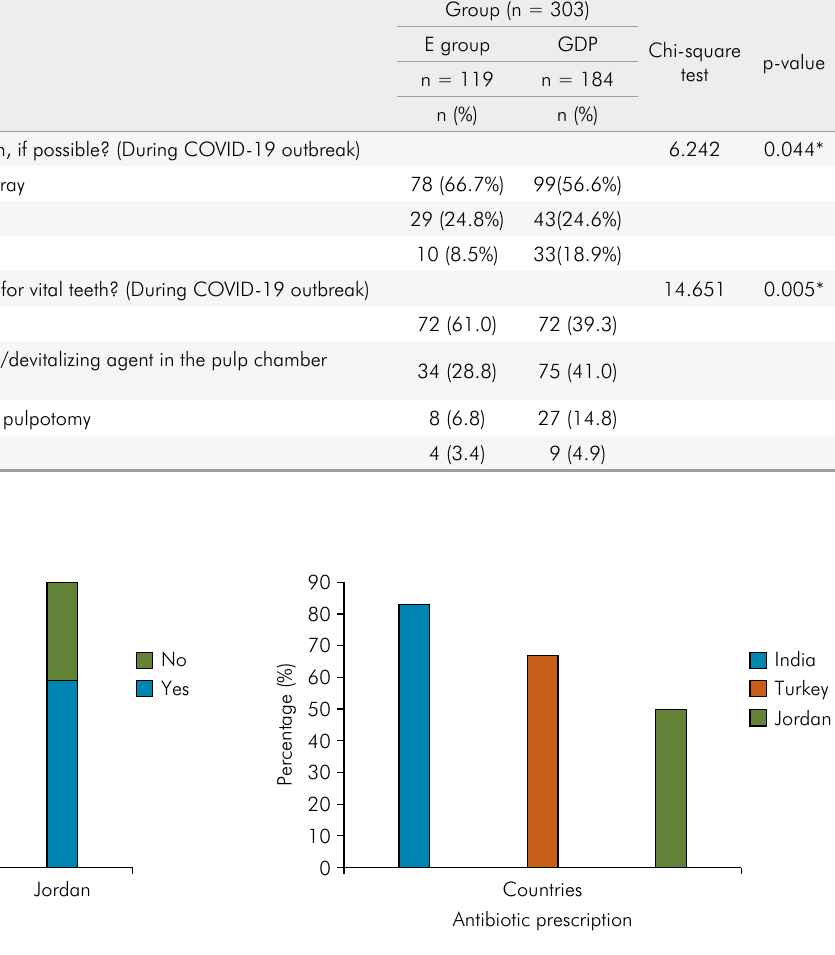
Figure 2. Comparison of remote consultation percentages for India, Turkey, and Jordan.